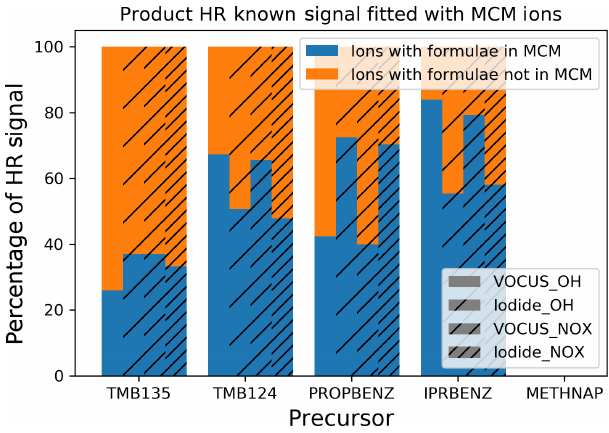
Figure 5. Comparison of the signal contribution of ions predicted to form by the MCM and those